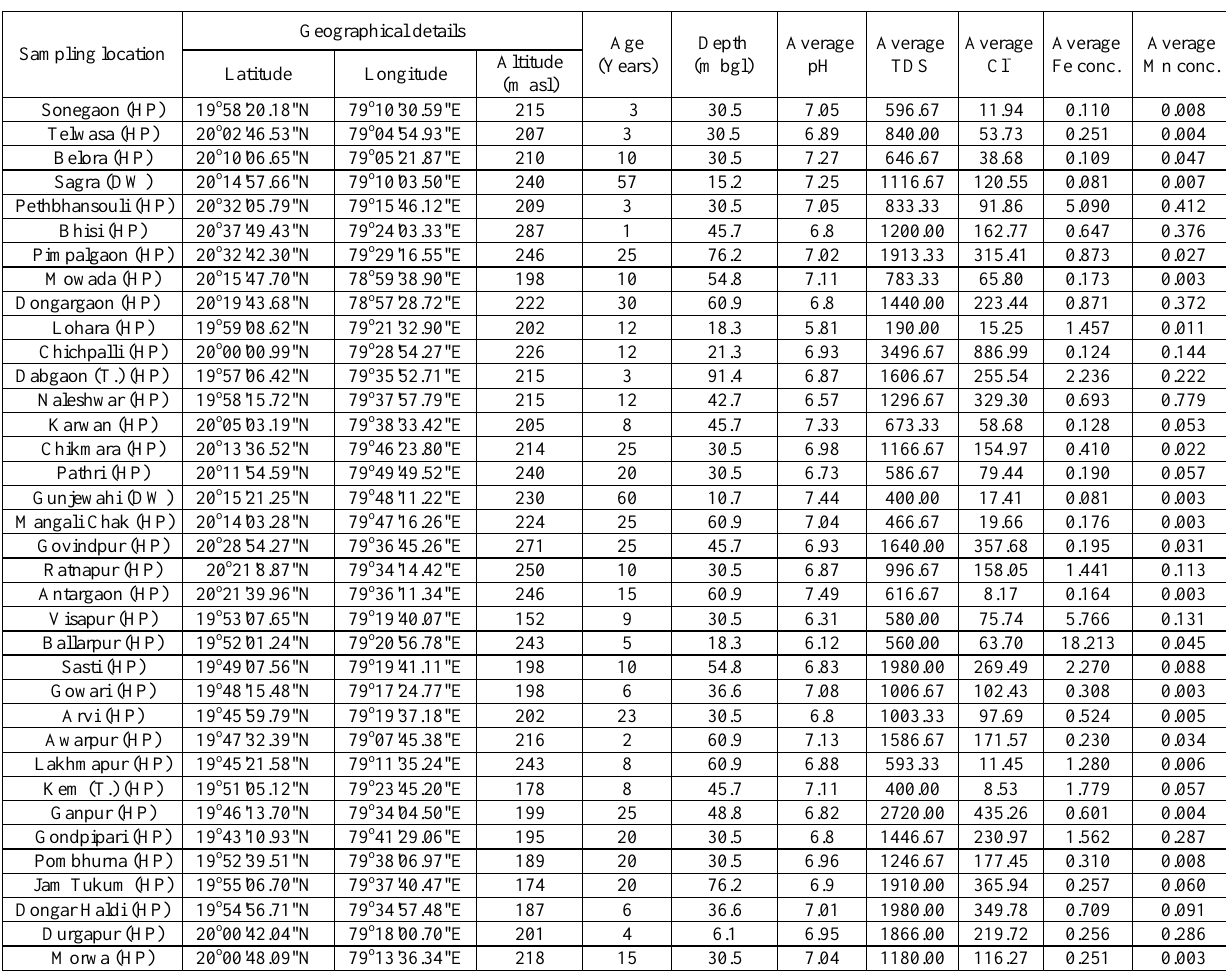
Table 1. Groundwater sampling locations and characteristics (Water source: HP - Hand Pump, DW - Dug Well; Age - age of the hand pump or dug well) Sampling